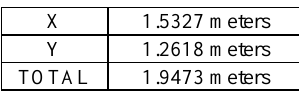
Table 6. Check Point